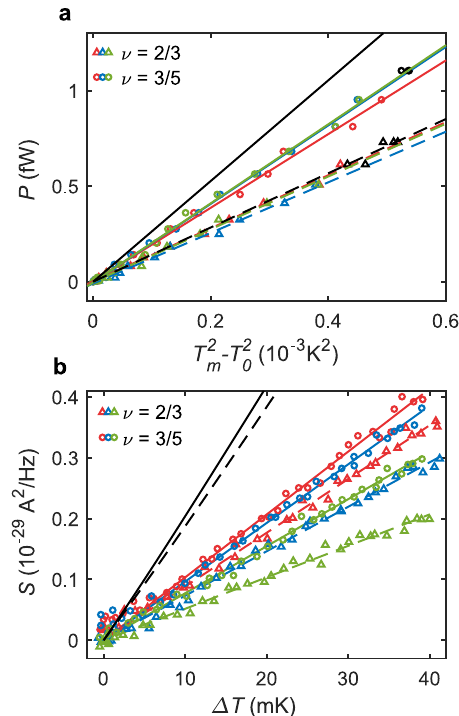
Fig. 4 Quantitative analysis of the thermal conductance and the (cid:2) T 2 , where T m upstream noise. a Dissipated power P as a function of T 2 m 0 and T are the Ohmic contact and the base temperatures, respectively. The 0 base temperature was separately calibrated (see Supplementary Note 2) and = 11mK at ν ¼ 3 = 5 and T = 14mK at ν ¼ 2 = 3. The colored found to be T 0 0 markers (low temperature data - T m < 25 mK ) were linearly fi tted to extract κ 2 T ( fi ts marked by colored dashed and full lines for ν ¼ 2 and ν ¼ 3 , respectively). 3 5 The black markers are high temperature points, which were not fi tted, since at these temperatures, the cooling of the central contact by lattice phonons becomes non-negligible. We plot the data for ν ¼ 2 and ν ¼ 3 for propagation 3 5 lengths 15 μ m (red) 45 μ m (blue), and 85 μ m (green). We fi nd length- independent, thermal conductances κ 2 T = κ 0 ¼ 1 : 00 ± 0 : 03, κ 2 T = κ 0 ¼ 1 : 45 ± 0 : 03 for ν ¼ 2 and ν ¼ 3 , respectively. The theoretically expected values 3 5 for ν ¼ 2 ( ν ¼ 3 ) are plotted as a black dashed (full) line. We fi nd excellent 3 5 agreement with the data for ν ¼ 2 , while the thermal conductance for ν ¼ 3 is 3 5 somewhat smaller than predicted. b Excess upstream noise as a function of T m for ν ¼ 2 and ν ¼ 3 , and for propagation lengths 15 μ m (red), 45 μ m (blue), 3 5 and 85 μ m (green). The slope of the linear fi t, denoted as 2 k B G 2 T f T in Eq. (3), increases with decreasing length (due to diminishing dissipation) and approaches a value of roughly 0 : 5 times that predicted by a microscopic calculation. The predicted values (see Supplementary Note 9) are depicted by the black, dashed, and solid line for ν ¼ 2 and ν ¼ 3 , 3 5